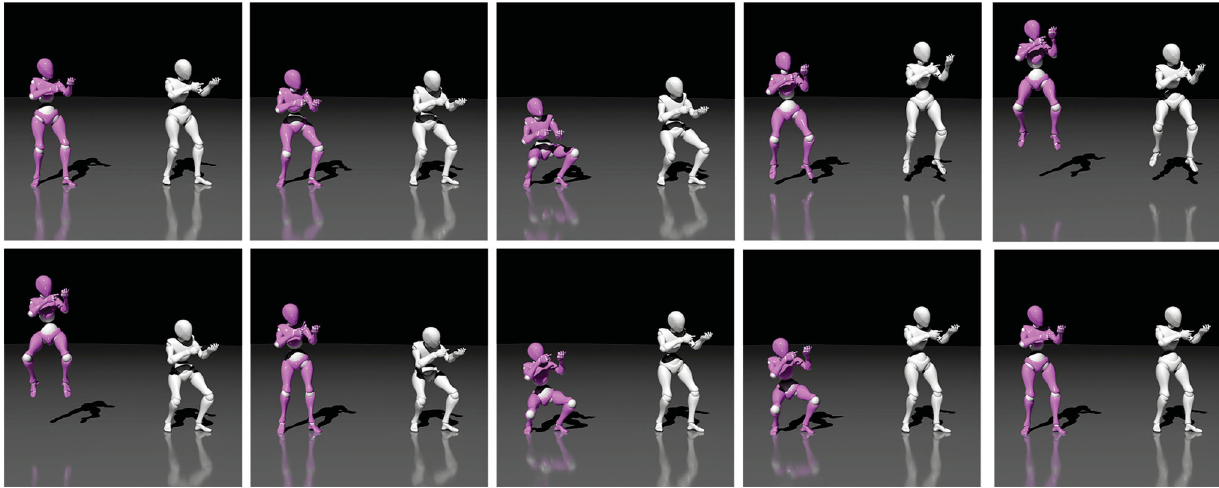
Fig. 17 Uniformly spaced frames extracted from a “Jumping” motion from Adobe’s Mixamo [48], before (right character in each panel) and after editing (left character) using our technique. The edits increase the height of the jump and deepen the crouching both before and after the jump. Also see the video in the ESM.